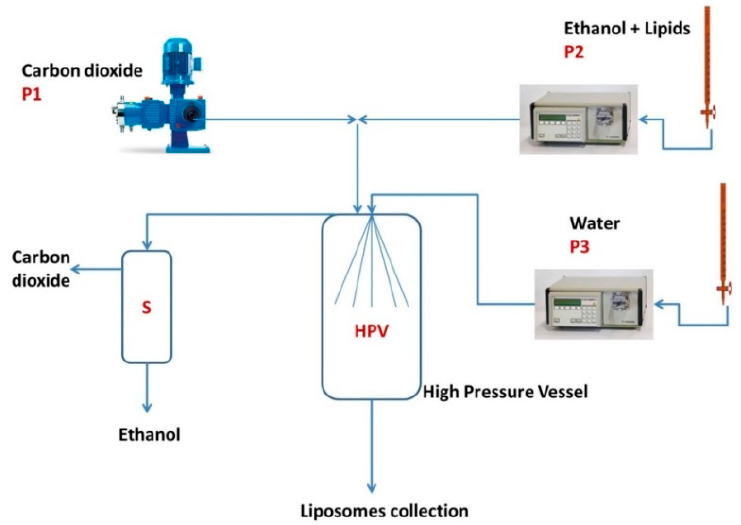
Figure 1. Experimental set-up of SuperLip process; P1 is the CO 2 pump, P2 is the ethanol pump, P3 the water pump, S stands for Separator, HPV is the High-Pressure Vessel. Liquid carbon dioxide was pumped to the system from a 30 L internal tank, where CO 2 was stocked at a temperature of 25 ◦ C and 60